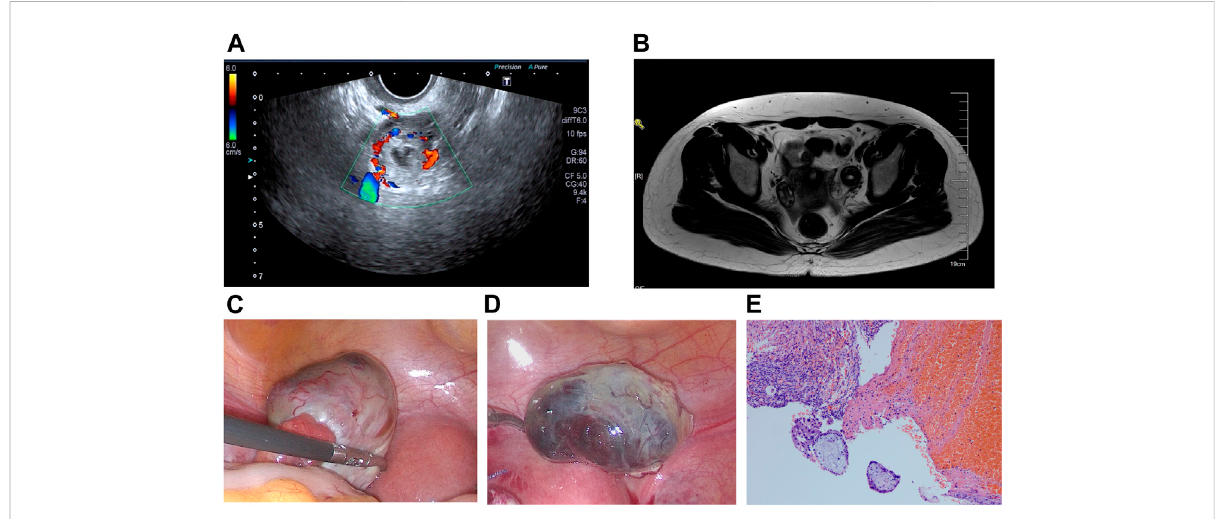
hCG value rises slowly, and the mass gradually increases (Figure 1A). Further pelvic magnetic resonance imaging (MRI) showed a quasi-circular mixed-signal nodule of